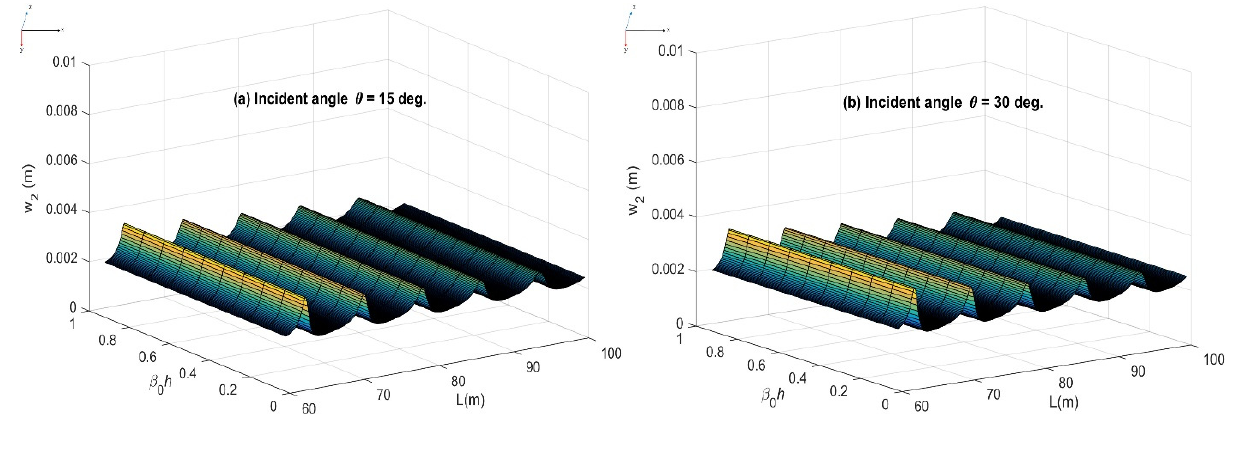
Figure 7. Effects of σ on the